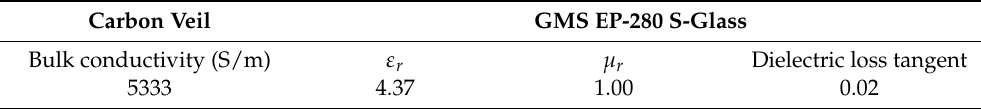
Table 3. Electromagnetic properties for gms ep-280 s-glass and carbon veil at 2.4